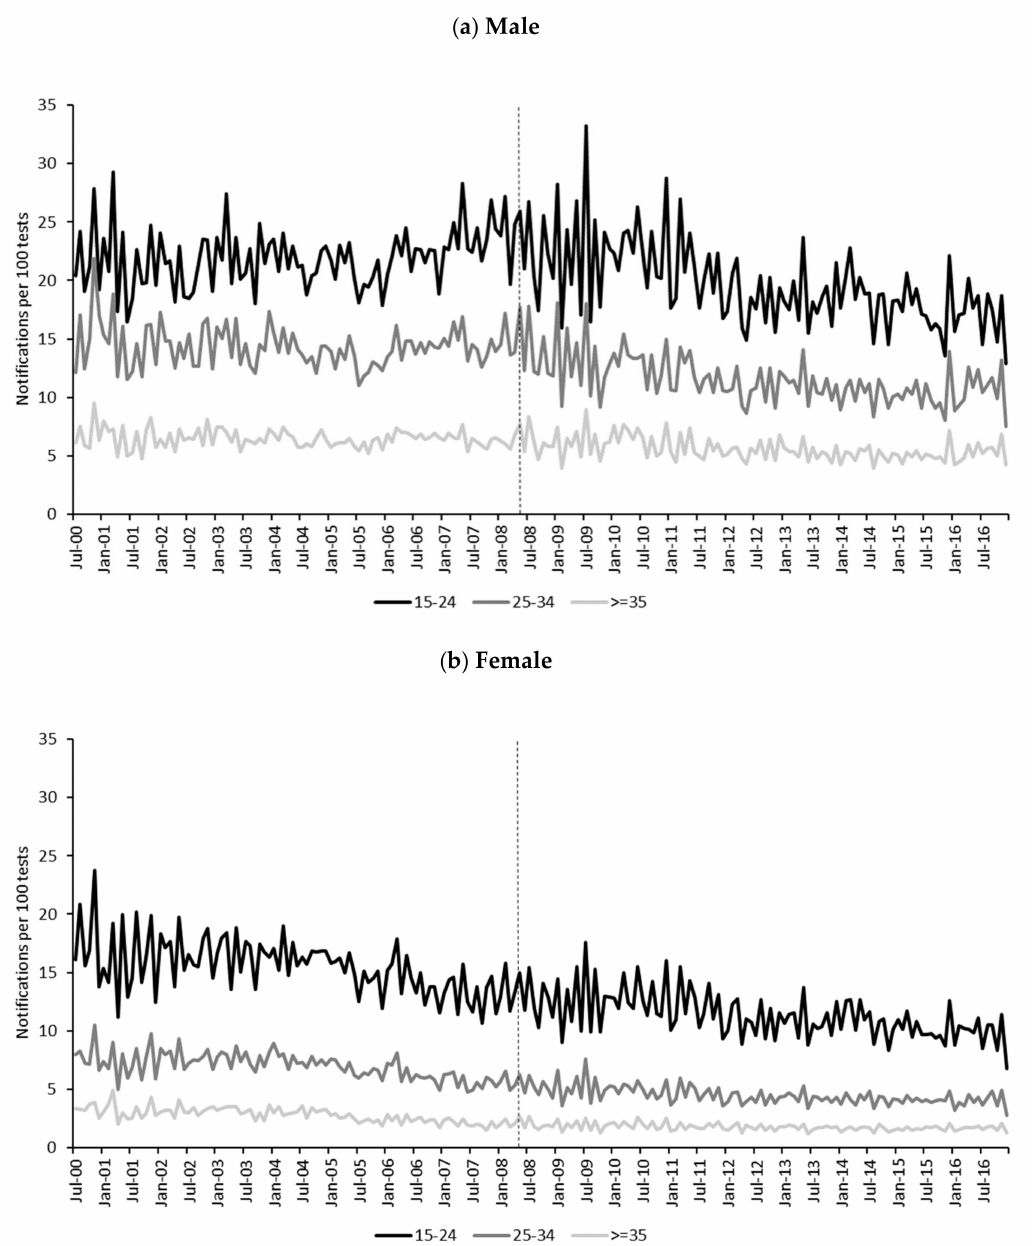
Figure 3. Monthly chlamydia test positivity rates (secondary outcome) by gender and age group, July 2000 to December 2016. Alcopops tax intervention point indicated by vertical dotted line at May 2008. Notification data were aligned with test data that were processed one month